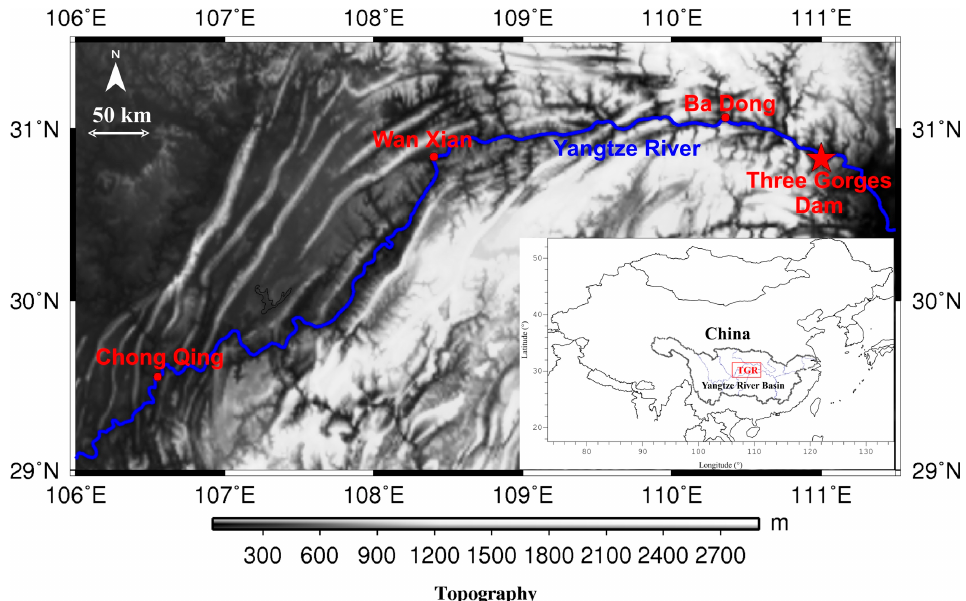
Figure 1. Topography and location of the Three Gorges Reservoir (TGR) study area. At maximum water level (175 m), the TGR stretches approximately 600 km along the Yangtze River (blue curve) from the TGD (red star) to Chongqing.